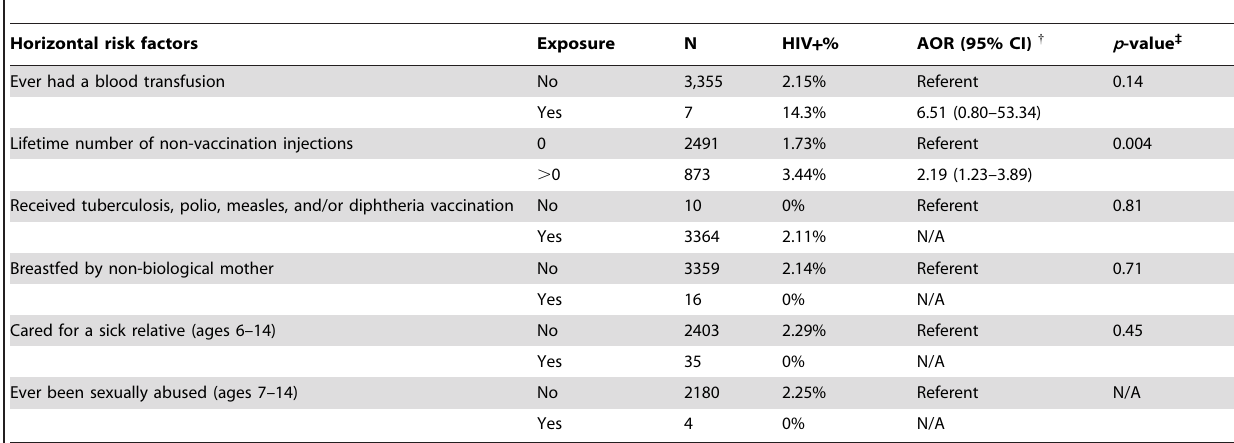
Table 3. Association between HIV status and potential horizontal risk factors for